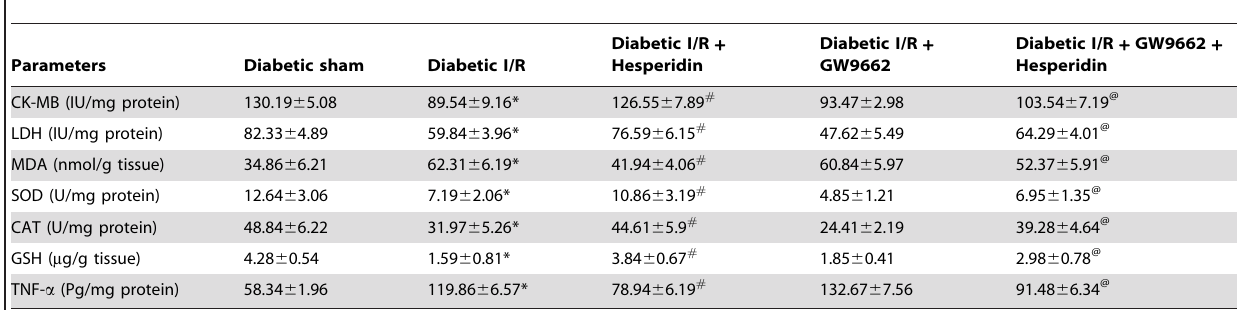
Table 1. Effect of hesperidin and GW9662 on cardiac injury marker enzymes, lipid peroxidation, TNF- a and antioxidant parameters.